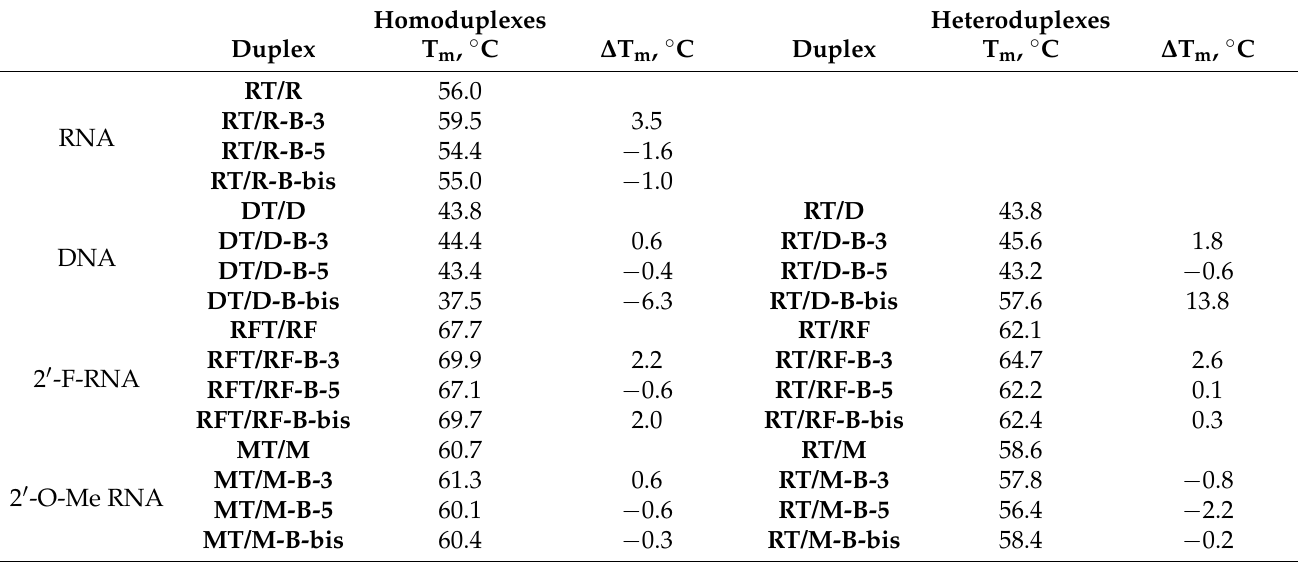
Figure 6. The differences between T m values for homoduplexes formed by non-modified parent oligonucleotides and by corresponding closo -dodecaborate conjugates. Table 2. The values of melting temperatures for homo- and hetero-duplexes of oligonucleotide conjugates and parent